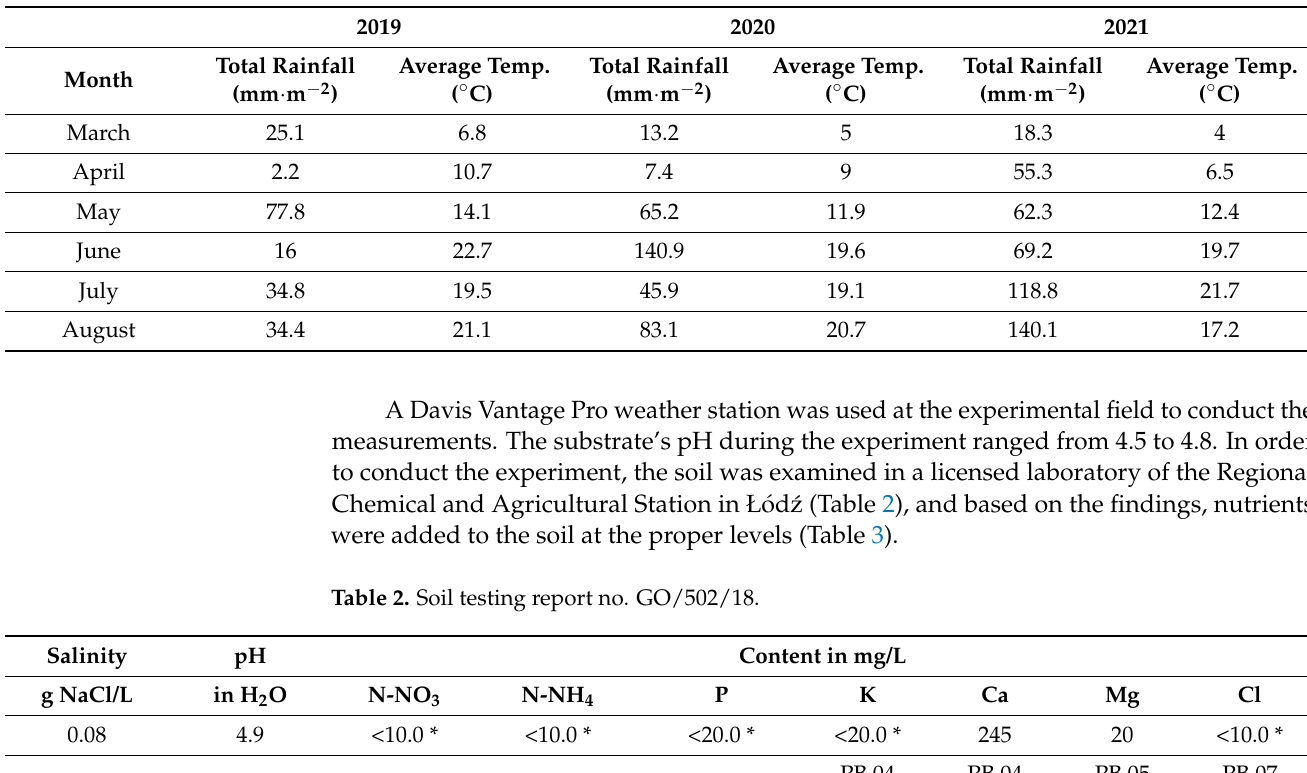
Table 1. Average air temperature and total rainfall recorded during the described experiment.